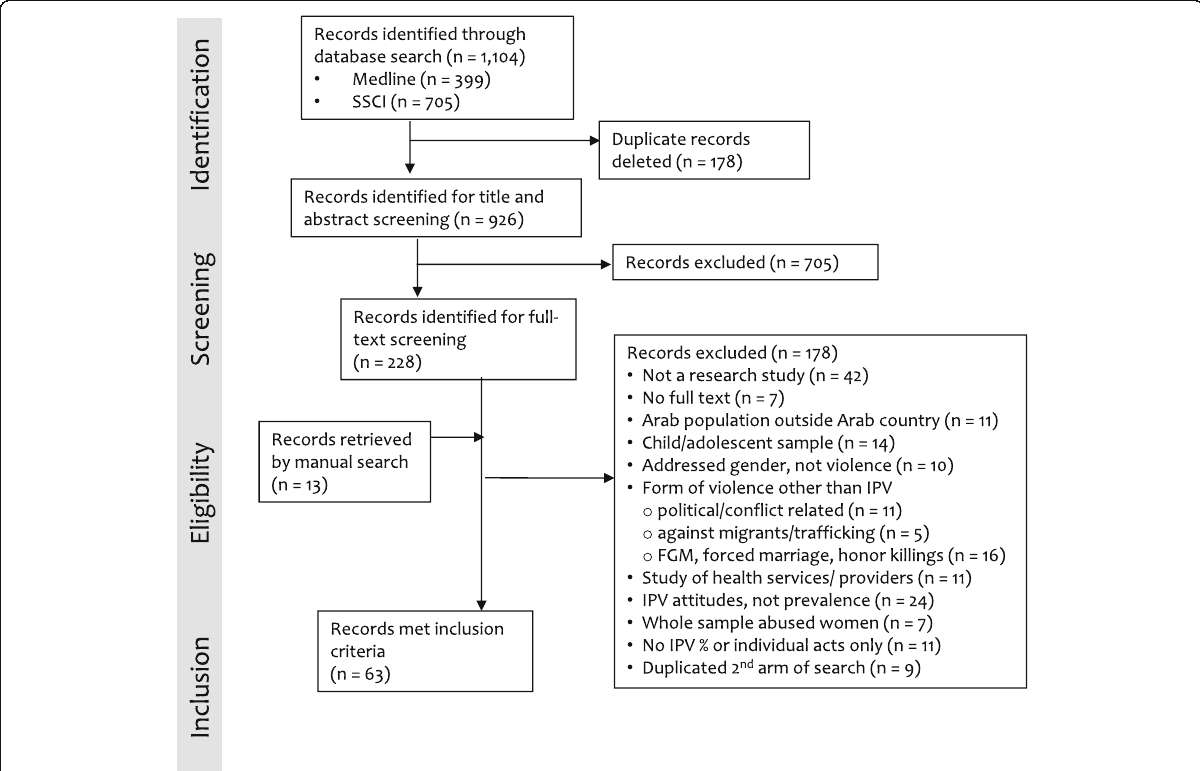
Fig. 1 Flowchart: Systematic search for eligible peer reviewed journal articles (records) with prevalence estimates of violence against women by intimate partners from the Arab region, January 2000 – January